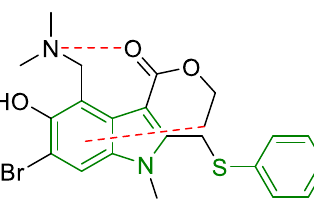
Figure 5. The indole and thiophenyl scaffold (green) interact with the hydrophobic membrane of influenza HA, whereby internal interactions (red lines) constrain the molecule to establish CH –π interactions with the amino-acid residues.